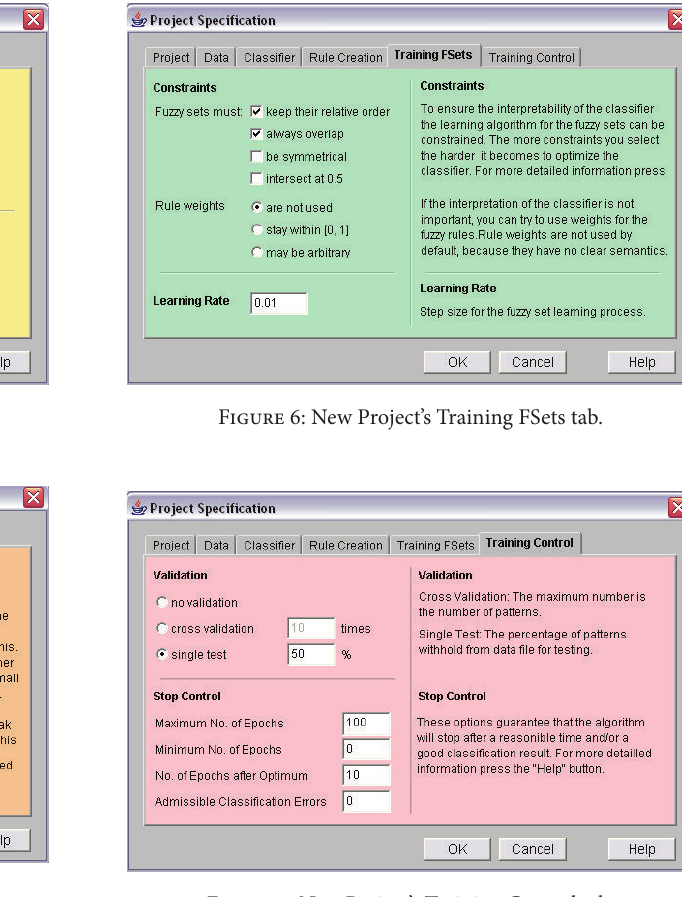
Figure 7: New Project’s Training Control